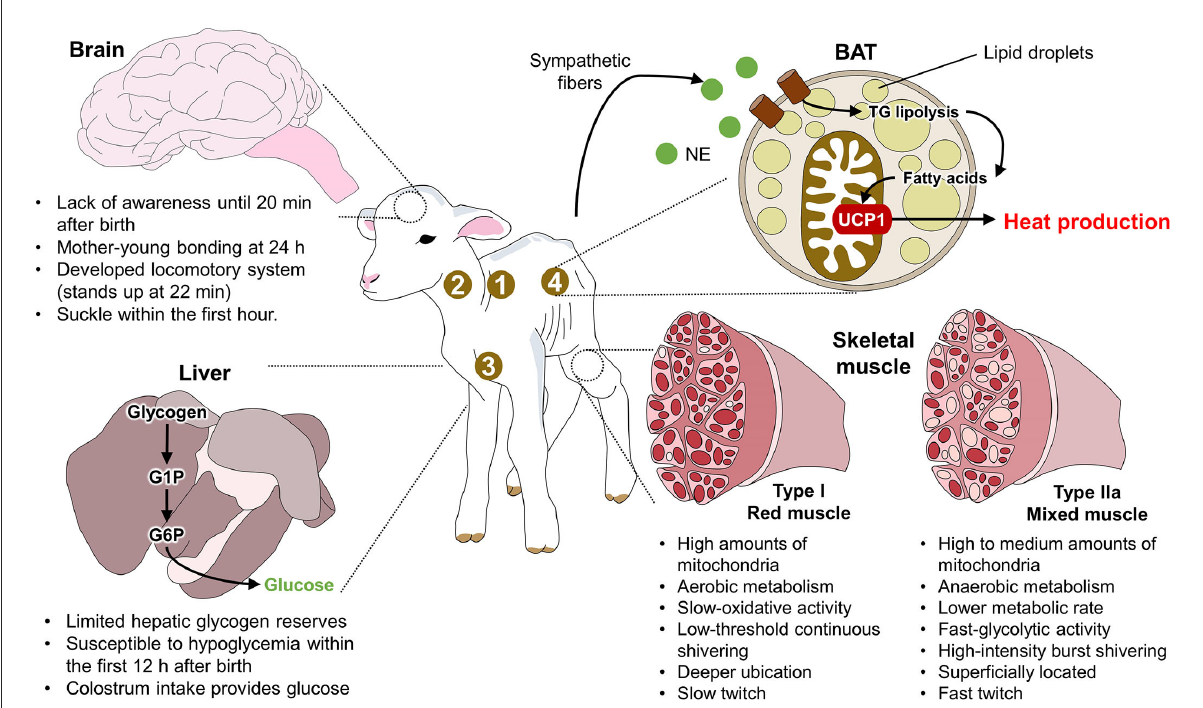
FIGURE1 Anatomical traits of newborn ruminants. 1. supraclavicular region; 2. neck region; 3. pericardial region; 4. perirenal region; BAT, brown adipose tissue; G1P, glucose 1 phosphate; G6P, glucose 6 phosphate; NE, norepinephrine; TG, triglycerides; UCP1, uncoupling protein